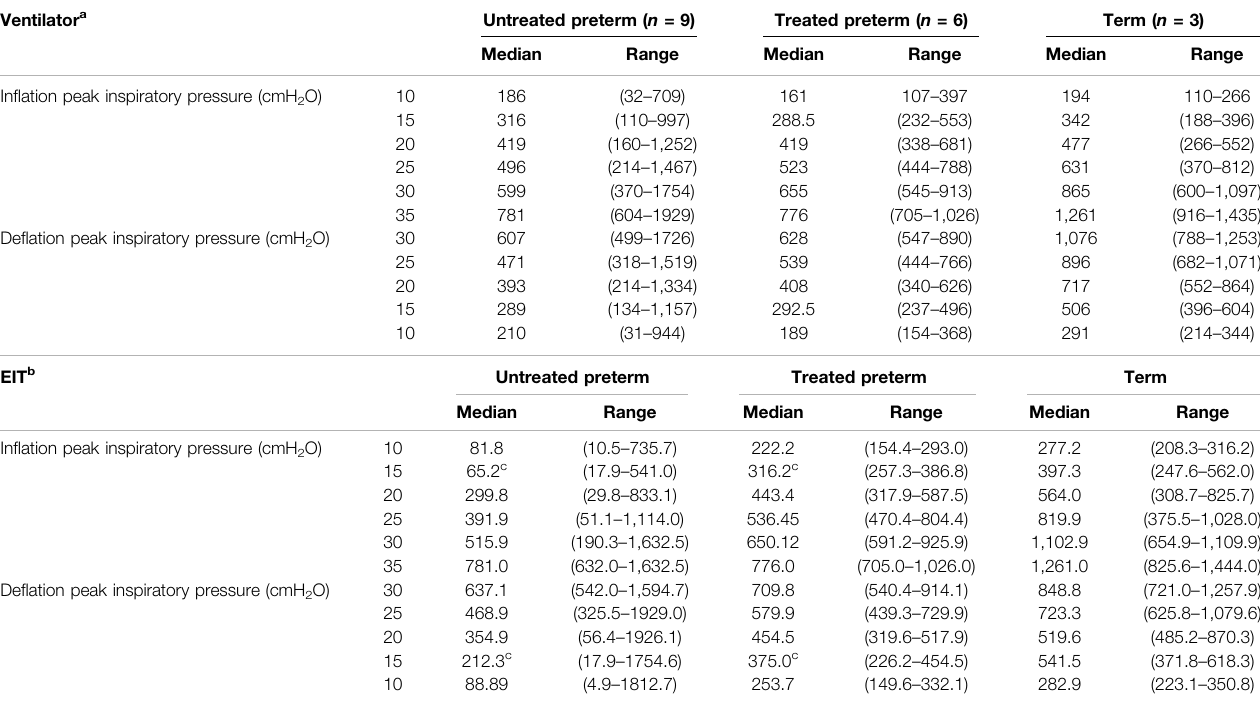
TABLE 1 | Measured tidal volumes according to stepwise in fl ation and de fl